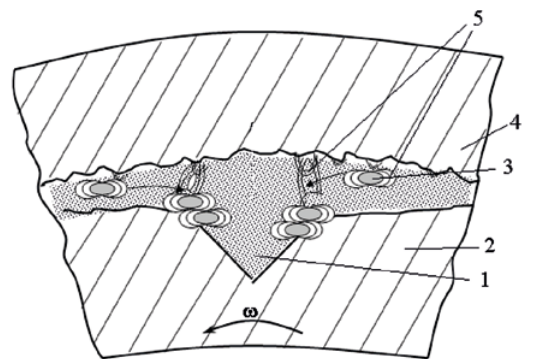
Fig. 4. Physical model of wear of a separate discrete area under conditions of limited lubrication: 1 – dimple; 2 – meting body; 3 – wear debris; 4 – sample; 5 – magnetic field